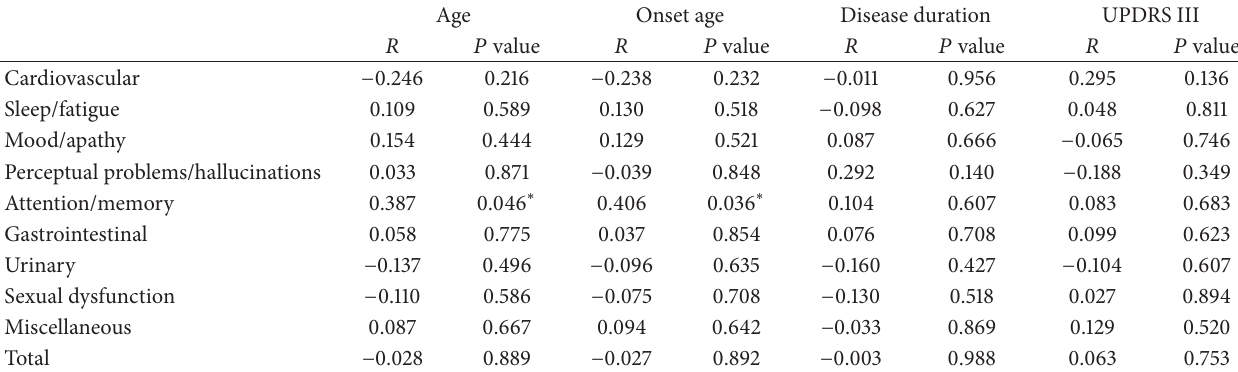
Table 4: Correlations between NMSS scores and clinical variables in PSP.